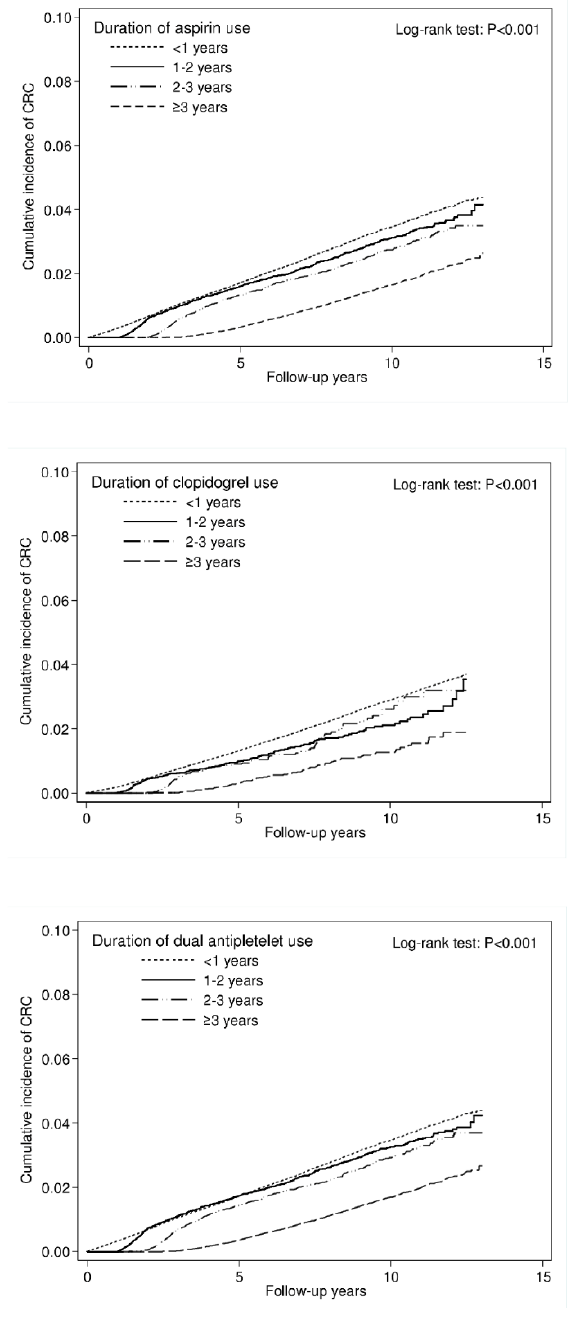
Figure 3. Cumulative incidence curve of CRC, stratified by duration.